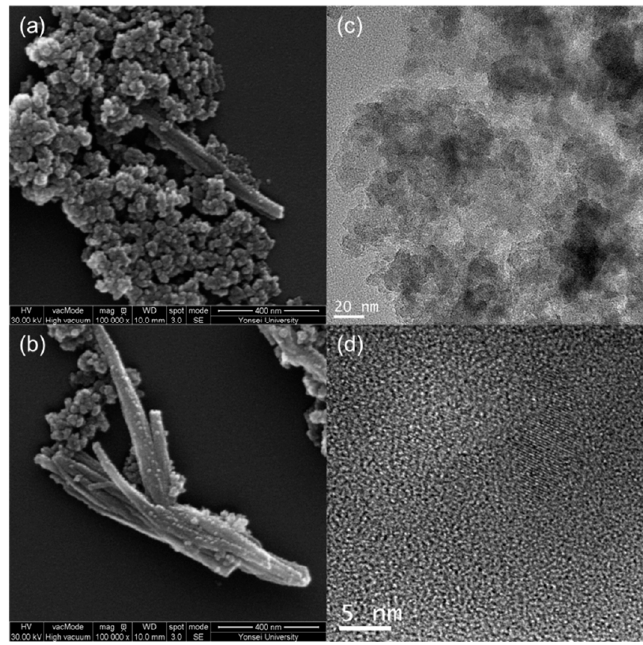
Figure 3. Morphology and pore texture of CPSH. SEM images ( a , b ) and TEM images ( c , d ).